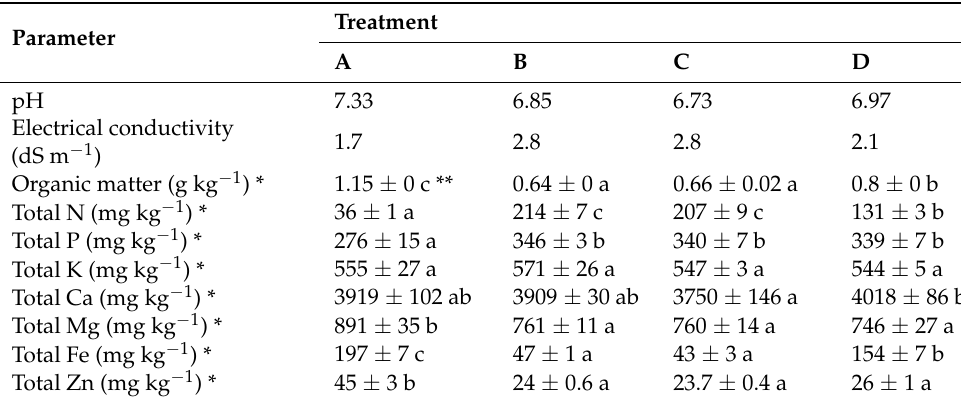
Table 4. Soil physicochemical properties from each